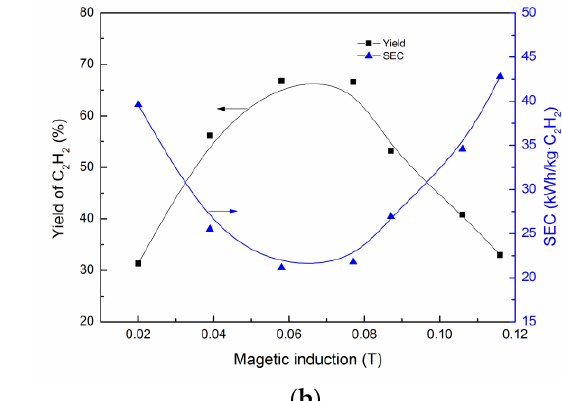
Q = 5.0 Nm 3 /h, Q = 5.0 Nm 3 /h, = 5.0 Nm 3 /h, m- n- hexane 2 H 2 H 2